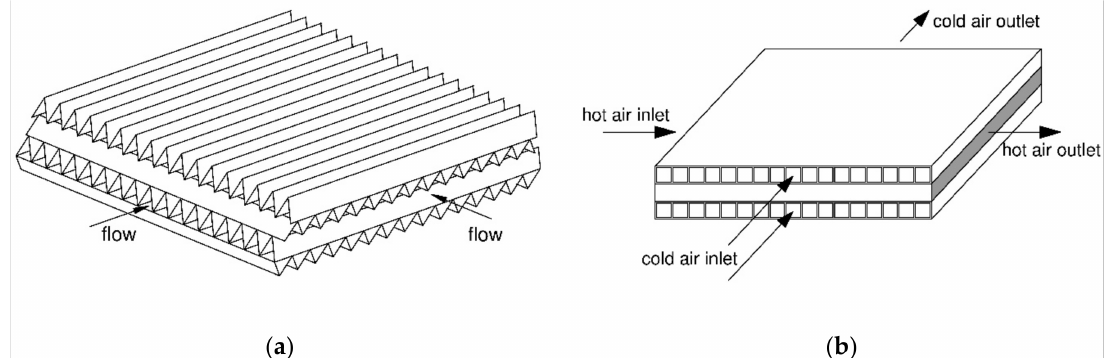
Figure 8. The fixed plate heat exchangers: ( a ) corrugated plates with triangular ducts [92], ( b ) rectangular plain fin shape [93].